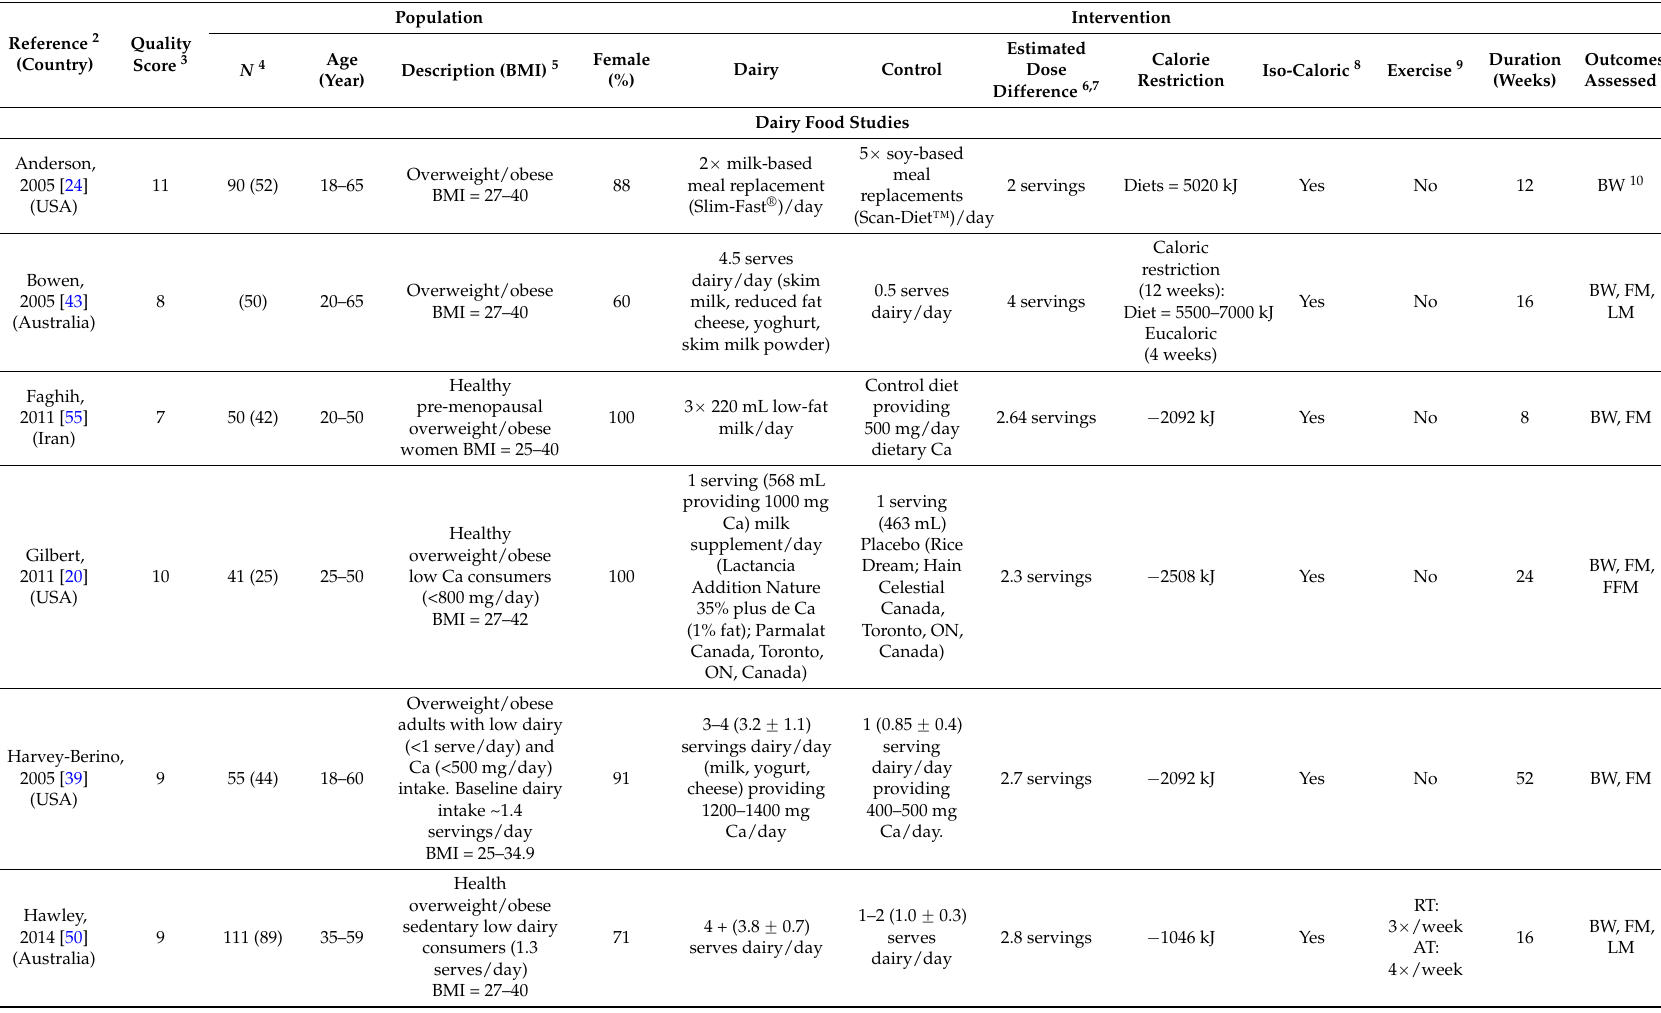
Table 1. Characteristics of randomized controlled trials included in the systematic literature review 1